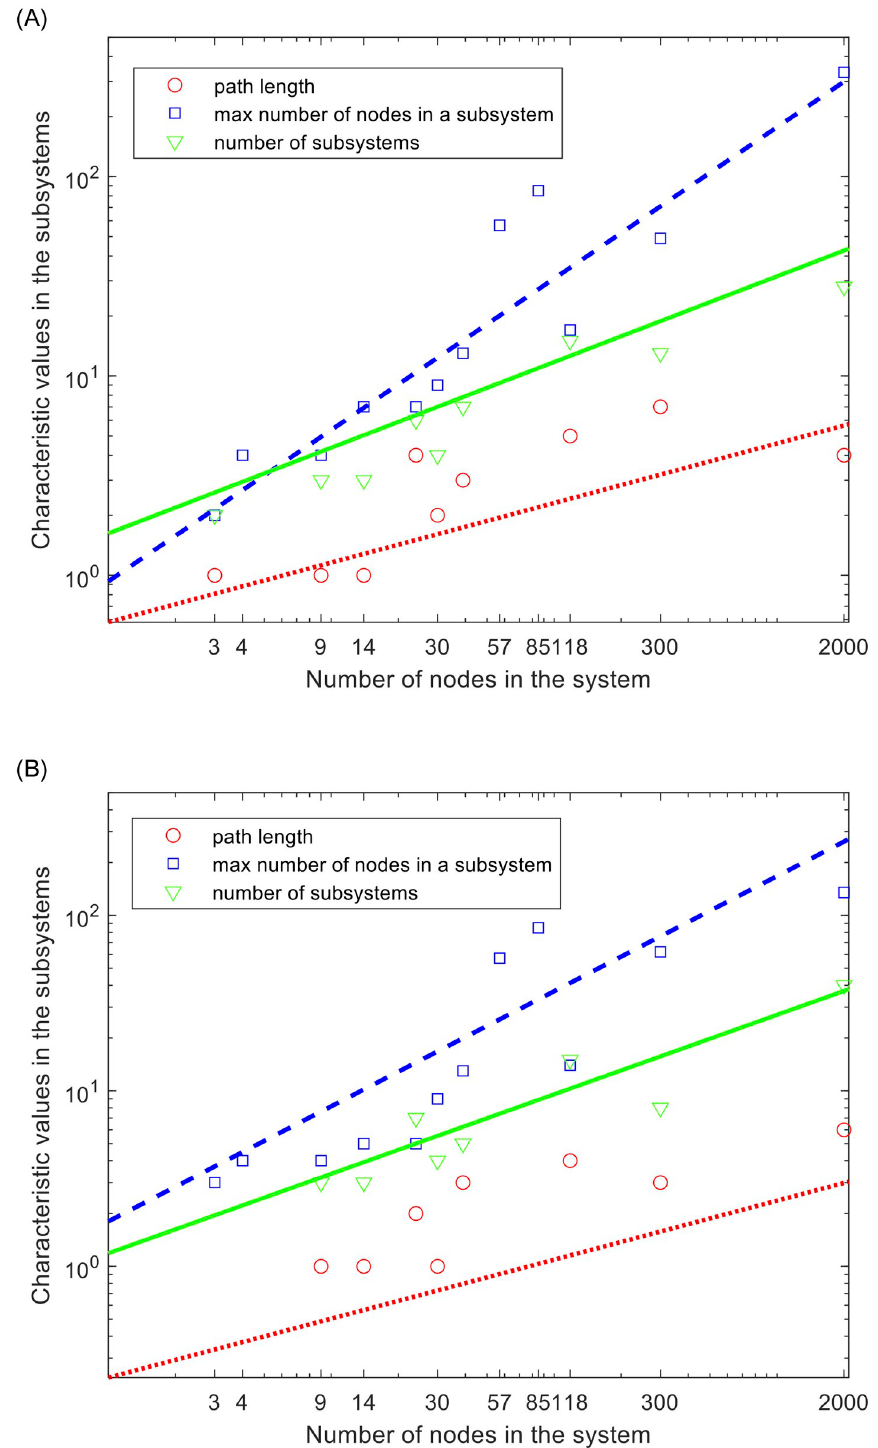
Fig 4. The path length, the maximum number of nodes in a subsystem, and the number of subsystems for the IEEE 3-, 4-, 9-, 14-, 24-, 30-, 39-, 57-, 85-, 118-, 300-, and 2,000-bus systems. The lines indicate the positive correlations on the size of the system. The red-dotted line, the blue broken line, and the green solid line represent the best-fit curves for the path length, the maximum number of nodes in a subsystem, and the number of subsystems, respectively. Two algorithms are applied for clustering nodes: (A) unnormalized algorithm, and (B) normalized based on the algorithm in [28].